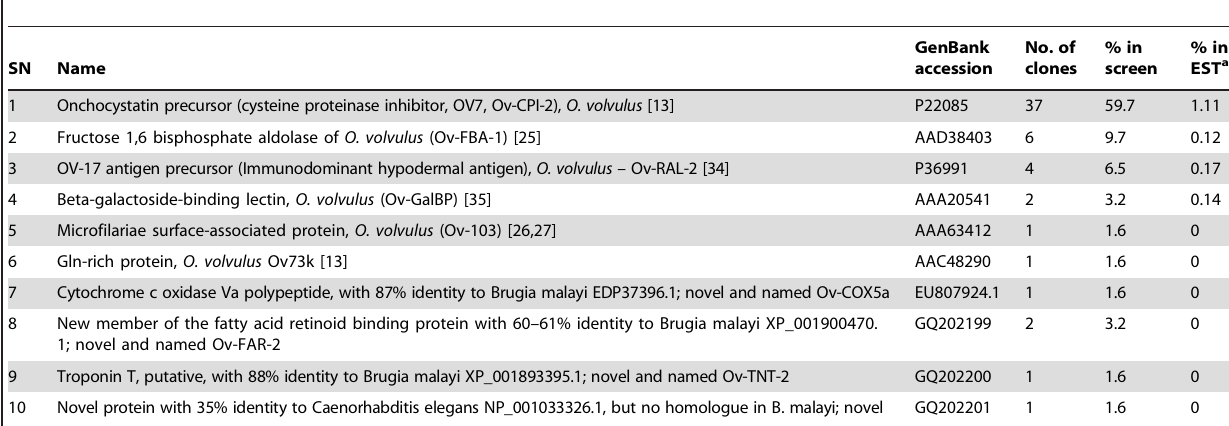
Table 1. cDNA clones isolated from the L3 cDNA